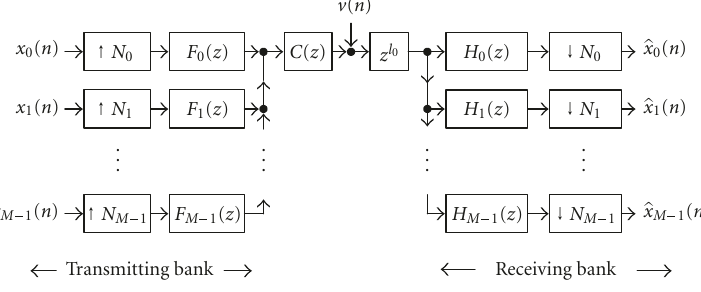
Figure 1: A nonuniform filter bank transceiver with integer sampling